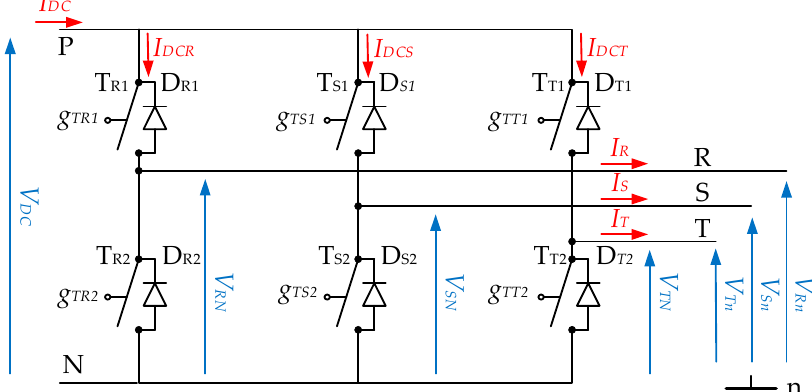
Figure 2. Two level three-phase inverter comprising the DC link (with V DC , I DC voltage, and current highlighted), six bidirectional switches (six active switches and six antiparallel diodes), and the output phase terminals (with phase current and voltages I RST , V RST-N , V RST-n , highlighted).